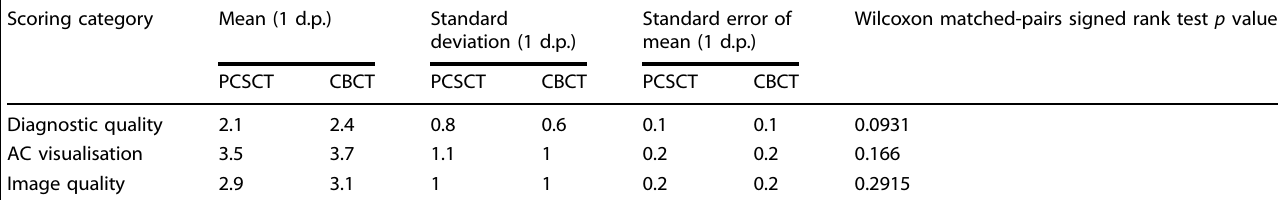
Table 4. Results from the statistical analysis, for the three different scoring categories, for PCSCT and CBCT, for the AC detection part of the paper (teeth 1 – 6). Scoring category